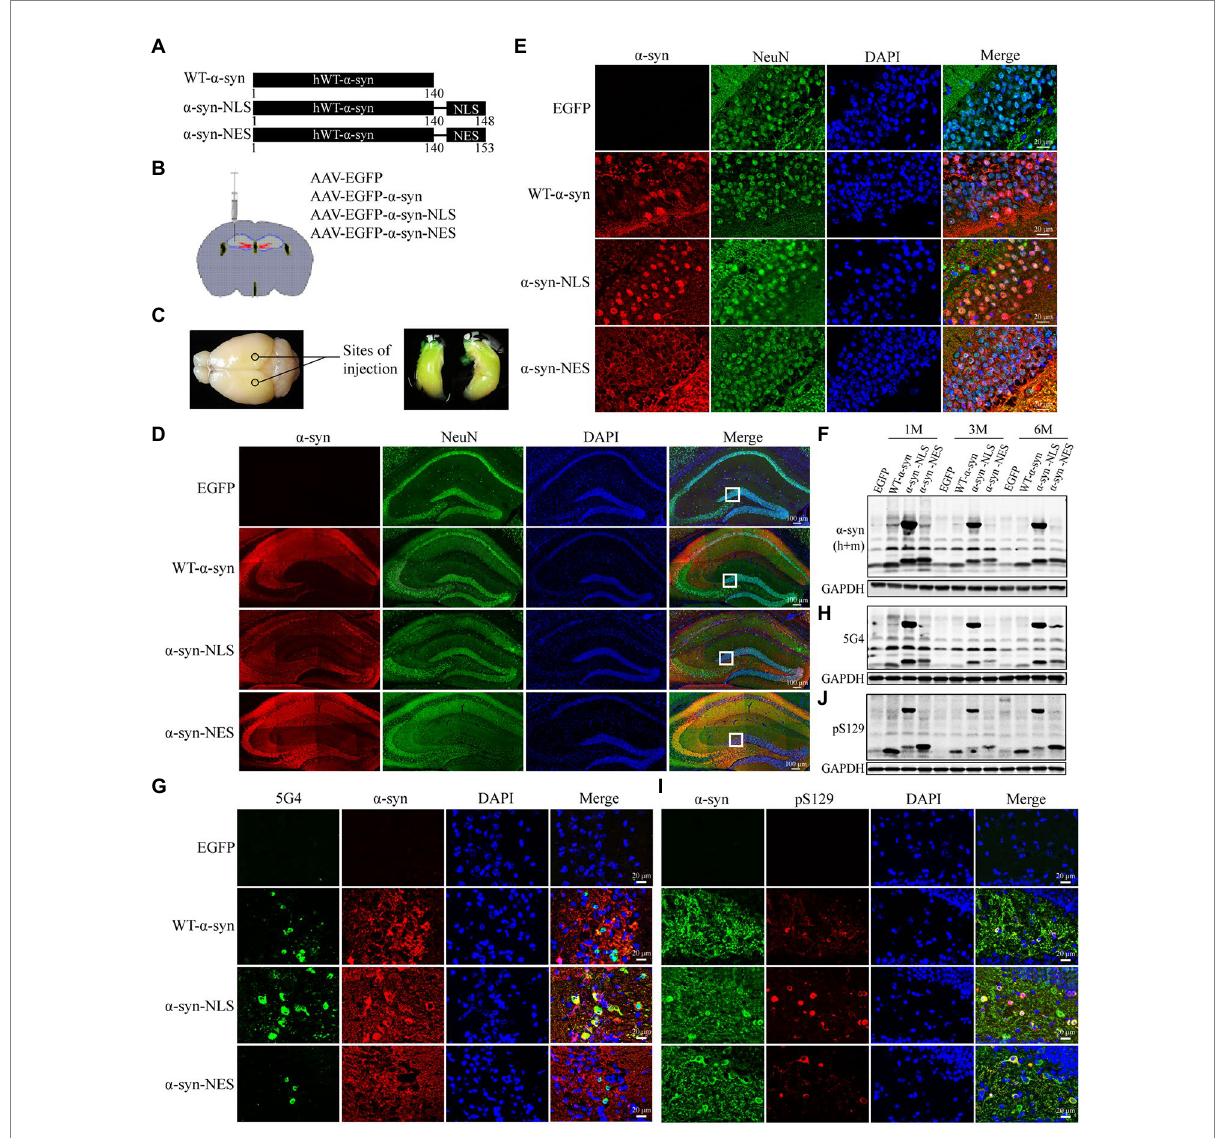
FIGURE 1 AAV carrying EGFP-SNCA -NLS was successfully expressed in the mouse hippocampus and caused significant accumulation of pathological α -syn. (A) Plasmids encoding for WT- α -syn, α -syn-NLS, and α -syn-NES were used as template to generate identical constructs to create rAAV2/9. (B) Injection sites in the hippocampal region of 6–8-weeks-old mice. (C) The virus spread in the hippocampal region of mice after injection. (D) Double fluorescent staining of mouse hippocampus with α -syn (red) and neuronal nuclear antigen (NeuN, green) antibodies; DAPI was used to stain all nuclei (blue). (E) Immunofluorescence staining reveals subcellular localization of α -syn in the hippocampus. (F,H,J) Level of total α -syn, α -syn aggregates (5G4) and Ser129 phosphorylation of α -syn (pS129) expression in mouse models was assessed by western blotting. (G) Immunofluorescence image of α -syn aggregates in the hippocampus. (I) Immunofluorescence image of Ser129 phosphorylation of α -syn in the